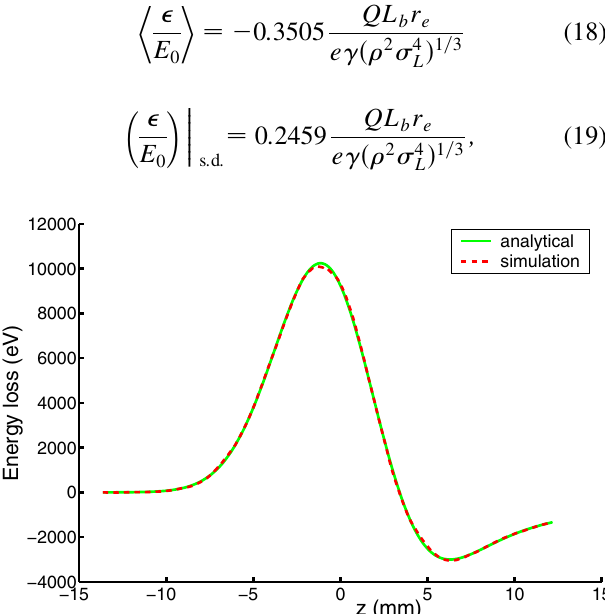
FIG. 2. (Color) Energy lost by the particles of a Gaussian bunch (cid:3) 3 mm , Q (cid:3) 1 nC ) after a dipole (Length: 1 m; bending ( (cid:10) L radius: 1.5